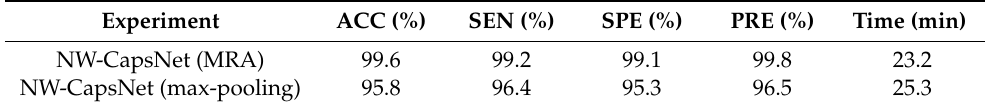
Table 2. Performance analysis between the MRA and max-pooling on NW-CapsNet. Experiment